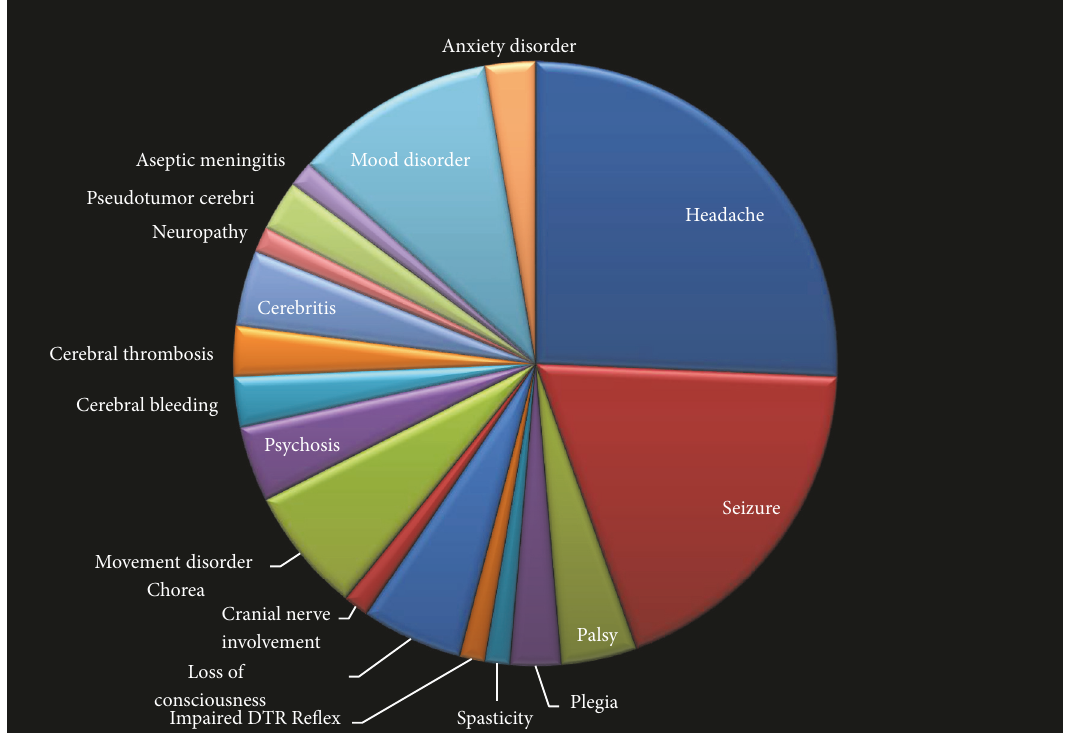
Figure 1: The prevalence of different neuropsychiatric manifestations of juvenile systemic lupus erythematosus.